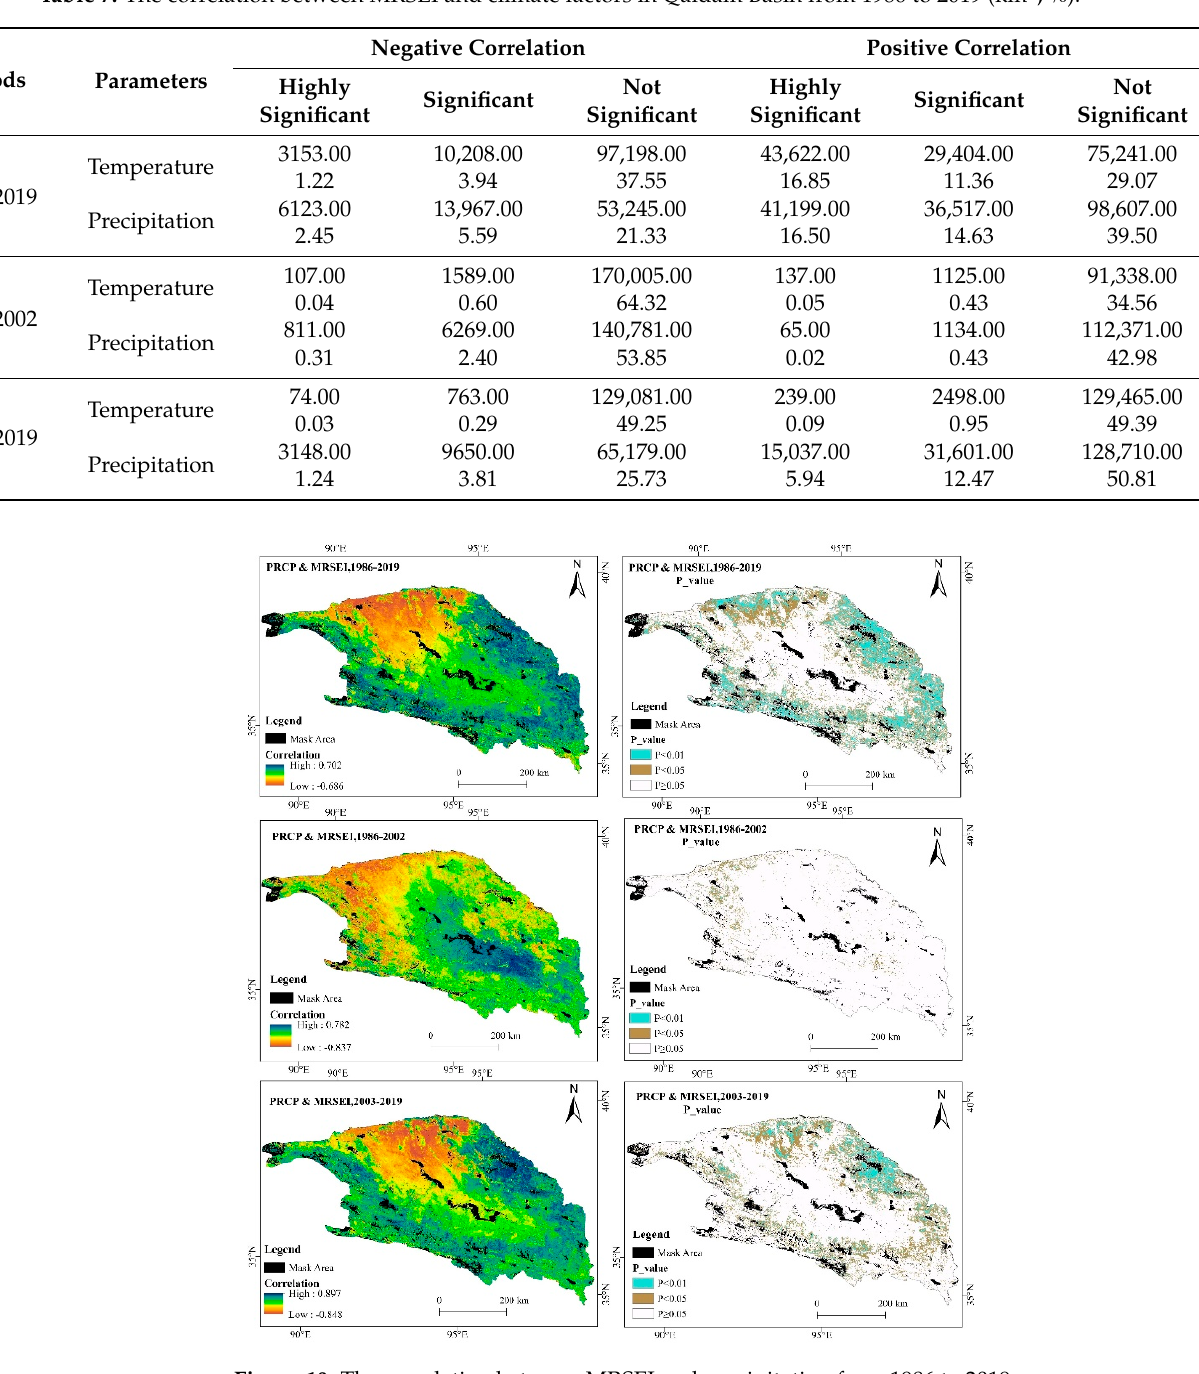
Figure 11. The correlation between MRSEI and temperature from 1986 to 2019.